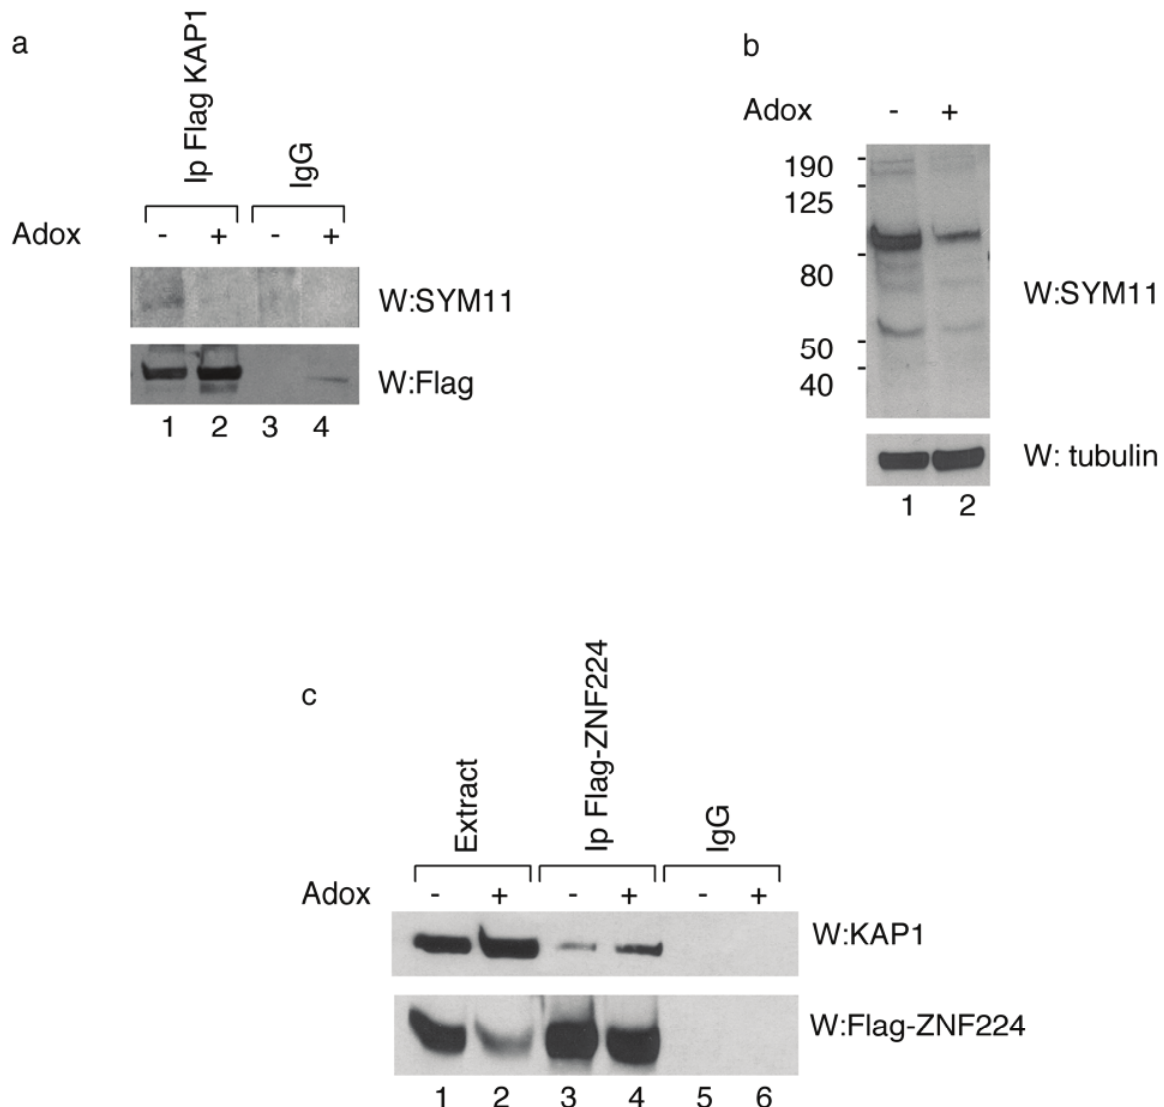
Figure 2. In vivo methylation of KAP1 affects its interaction with ZNF224. ( a ) Immunoprecipitation of methylated KAP1 protein. KAP1 exogenously expressed in HEK293 in the absence or presence of AdOx treatment was immunoprecipitated with anti-Flag antibody or control immunoglobulin (IgG), as indicated. After immunoprecipitation, Western blot analysis was performed with SYM11 antibody. A relative amount of immunoprecipitated Flag-KAP1 was visualized by Western blot analysis with anti-Flag antibody; ( b ) To verify the inhibition of protein methylation after 24h of AdOx treatment, whole cell extracts of HEK293 cells treated or untreated with AdOx were immunoblotted with anti-tubulin or SYM11 antibodies; ( c ) Interaction between KAP1 and ZNF224 is enhanced by AdOx treatment. Cell lysates from HEK293 cells transfected with Flag-ZNF224 in the absence or presence of AdOx treatment were immunoprecipitated with anti-Flag or anti-IgG antibodies; Western blot was performed using antibodies against KAP1 protein. A relative amount of immunoprecipitated Flag-ZNF224 was visualized by Western blot analysis with anti-Flag antibody. One representative experiment out of two performed is